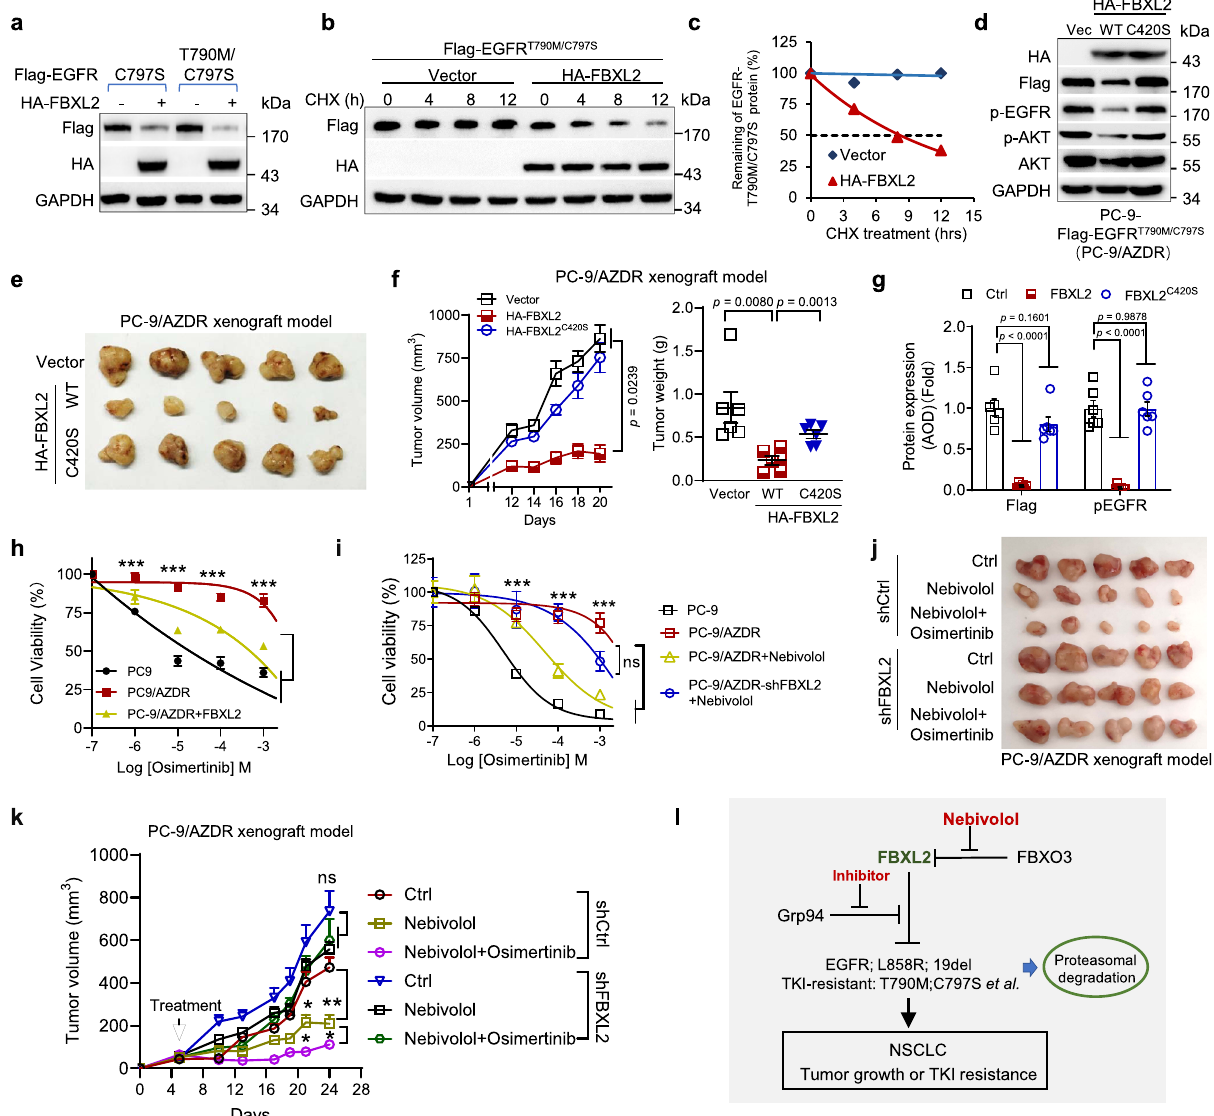
Fig. 7 Activation of FBXL2 overcomes osimertinib resistance of NSCLC. a HEK293T cells were co-transfected with indicated expressing plasmids for 36 h, followed by Western blot analyses. Data are representative immunoblots of three independent assays. b , c HEK293T cells were co-transfected with Flag- EGFR T790M/C797S in the presence of HA-FBXL2 or a vector control for 36 h, and were then treated with 50 µ g/mL cycloheximide (CHX) for an indicated time interval prior to Western blot analyses. The EGFR protein levels were quanti fi ed and a plot representing protein half-life was presented. PC-9-Flag- EGFR T790M/C797S cells stably expressing HA-FBXL2 or HA-FBXL2 C420S were subjected to d Western blot analyses or e − g xenograft tumor growth assays ( n = 6/group). Photos of tumor, growth curve, and tumor weight were presented. Paraf fi n-embedded tumors were subjected to IHC analyses. Data were quanti fi ed by AOD. Data were presented as means ± SEM. h PC-9 cells stably expressing EGFR T790M/C797S (PC-9/AZDR) were infected with lentivirus encoding HA-FBXL2. Cells were treated with an indicated dose of osimertinib for 72 h prior to MTS analyses. Data derived from three independent experiments in triplicates were presented as means ± SD. *** p < 0.001. i PC-9/AZDR cells stably expressing shFBXL2 were treated with an indicated dose of osimertinib in the absence or presence of 5 μ M nebivolol for 48 h followed by MTS assays. Data from three independent experiments in triplicates were presented as means ± SD. j , k PC-9/AZDR stable cells (2 × 10 5 ) were subjected to xenograft tumor growth assays ( n = 5/group). Mice were administrated with nebivolol alone or in combination with osimertinib. Photos of tumors and tumor growth curves were shown. Data were presented as means ± SEM. l A working model. The E3 ubiquitin ligase FBXL2 targets EGFR and EGFR mutants for proteasomal degradation, resulting in inhibition of tumor growth and TKI resistance of NSCLC. Grp94 binds to and protects EGFR from FBXL2-mediated degradation. The FDA-approved drug nebivolol can disrupt FBXO3 − FBXL2 interaction to stabilize FBXL2 and degrade EGFR, thereby inhibiting both NSCLC growth and TKI resistance.* p < 0.05, ** p < 0.01, *** p < 0.001; all by two- tailed Student ’ s t -test. Source data are provided as a Source data fi the notion that FBXL2 is a tumor suppressor through targeting mainly dependent on EGFR signaling. Firstly, FBXL2-mediated and promoting EGFR degradation, consequently leading to inhibition of cell proliferation and tumor growth can be com- inhibition of EGFR downstream signaling and suppression of pletely rescued by restoration of EGFR expression. Secondly, tumor growth. Importantly, our results show that inhibitory FBXL2 inhibits cell proliferation in H292, PC9 or H1975 cells, all effects of FBXL2 on cell proliferation and NSCLC growth are of which bear wild-type Ras alleles, while it exhibits little effects